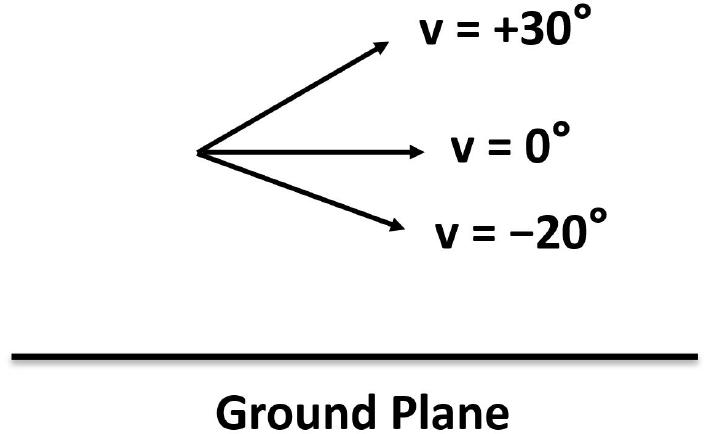
Figure 1. Vertical angle v where v = 0 ◦ is parallel to the ground